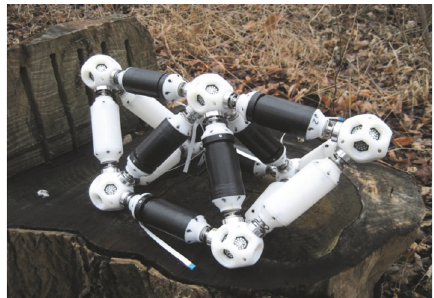
Figure 16: Odin MSRR (http://modular.tek.sdu.dk/index.php?page=